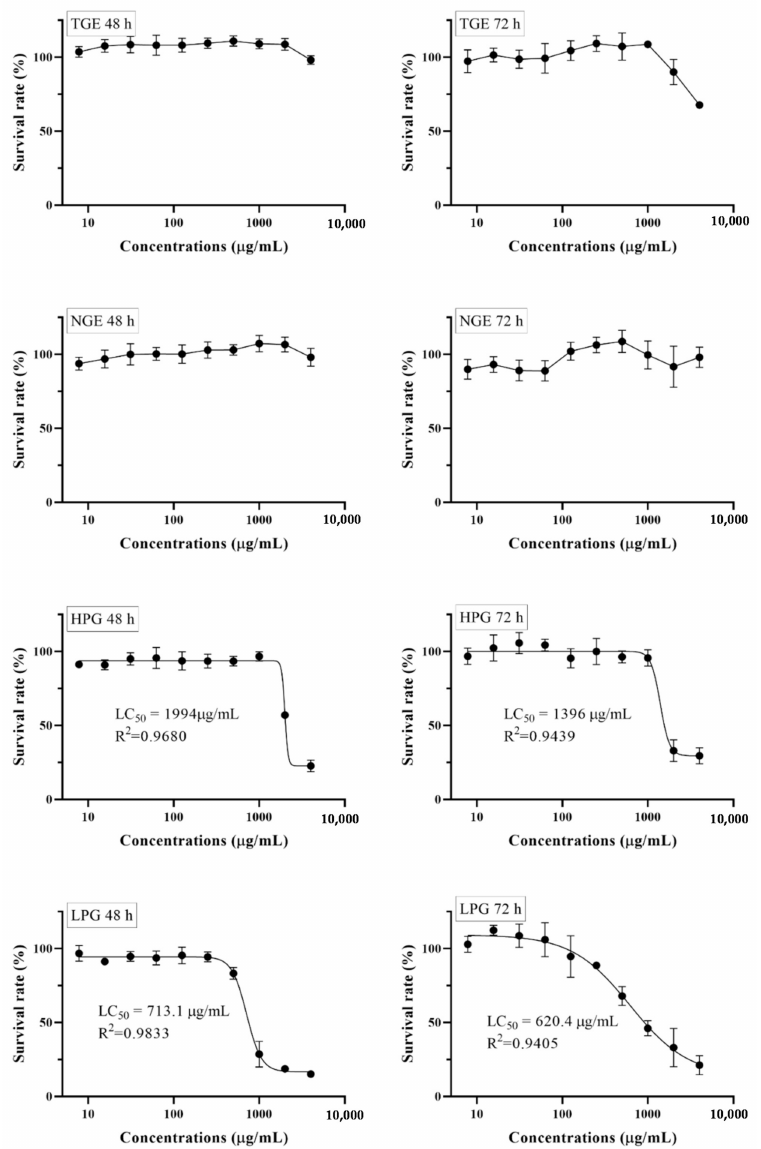
Figure 2. MTT dose-response relationship of ginseng fraction extracts after 48 and 72 h incubation with THP-1 cells assessed by an MTT viability assay. Values are expressed as a percentage of untreated control cells (mean ±